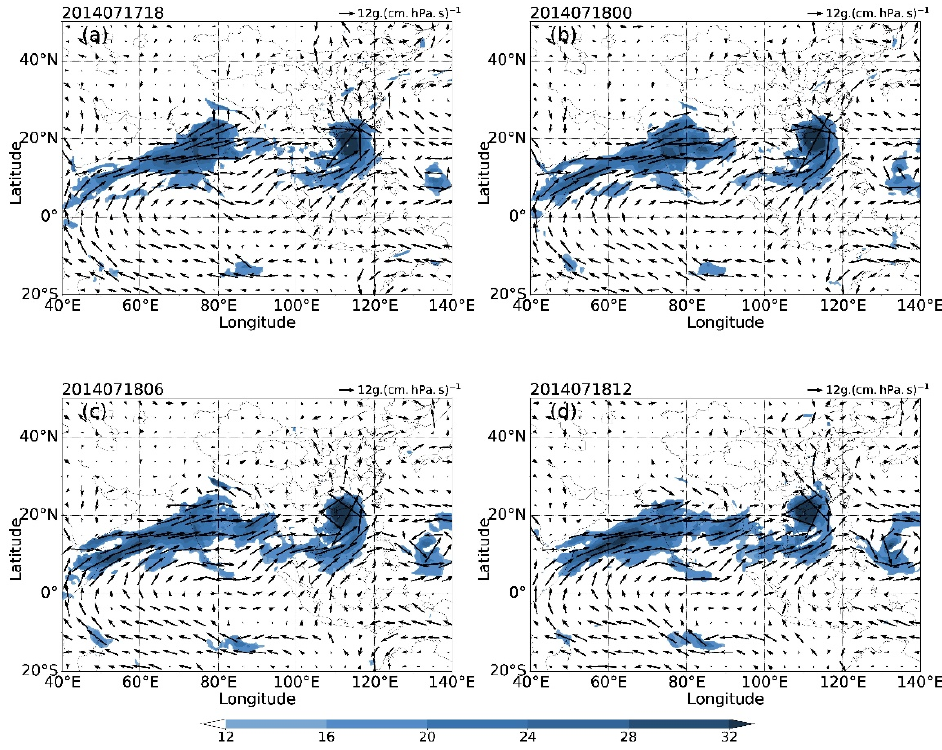
Figure 4. The 850 hPa water flux (vector, units: g · s − 1 · hPa − 1 · cm − 1 ) at ( a ) 18 UTC 17 July; ( b ) 00 UTC 18 July; ( c ) 06 UTC 18 July; ( d ) 12 UTC 18 July. The shading shows the water vapor flux greater than or equal to 12 g · s − 1 · hPa − 1 · cm − 1